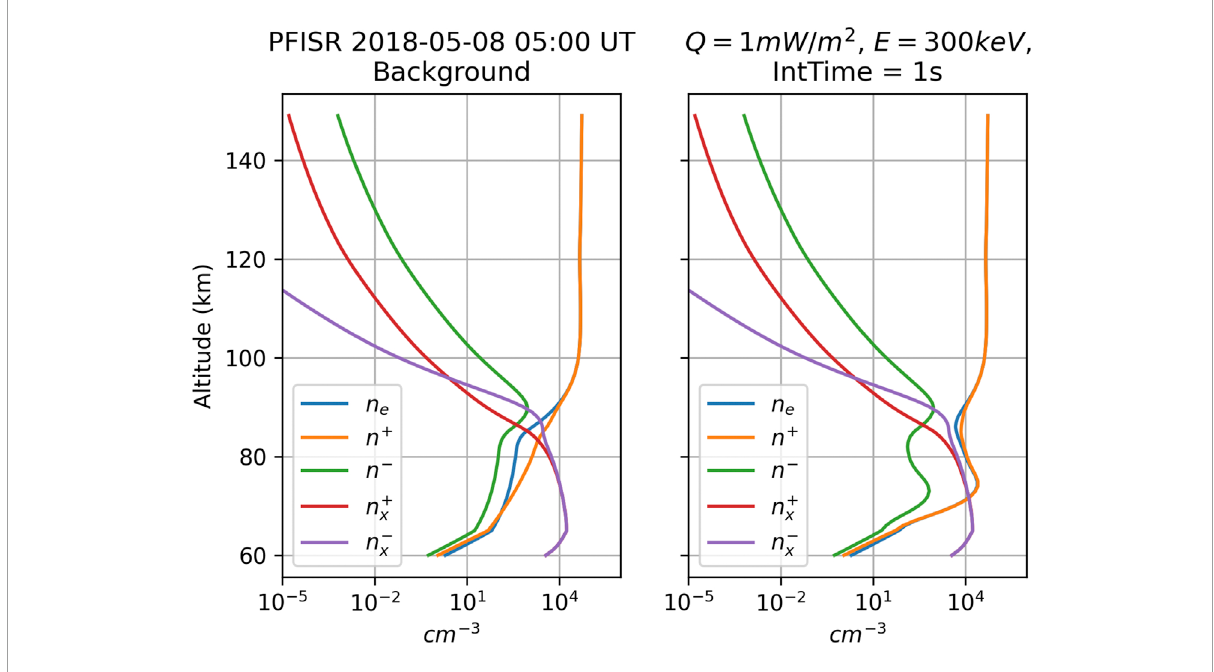
FIGURE 3 The altitude profiles of the positive and negative heavy and light ions, and the electrons. The left column shows the altitude profiles for the background, corresponding to IRI, at PFISR on 08 May 2018 at 0500 UT. The right panel shows the same time interval, but now including a monoenergetic beam with energy 300 keV and an energy flux of 1 mW / m 2 . The equations are integrated for 1 s.